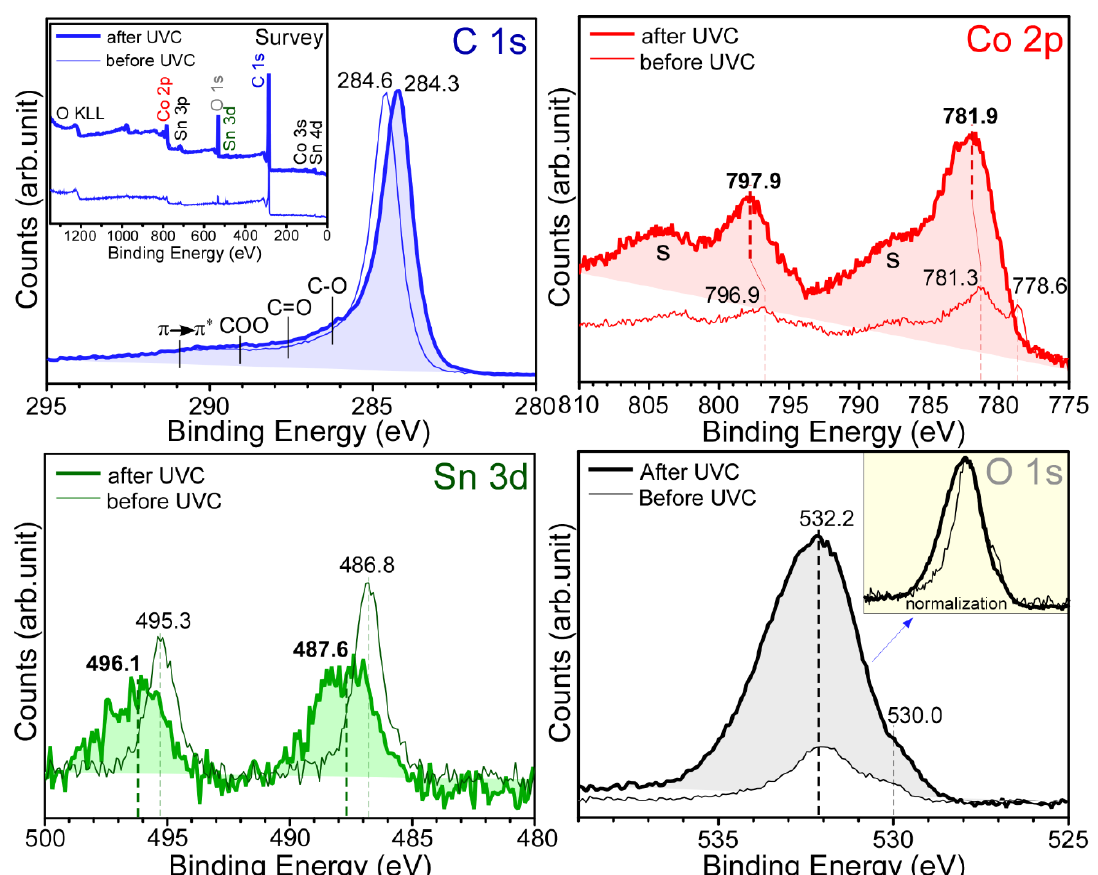
Figure 3. C 1s, Co 2p, Sn 3d, and O 1s XPS profiles of the selected (10 mol% SnO 2 ) sample before (thin line) and after (thick line) CO 2 reduction. The insets of C 1s and O 1s show survey XPS and normalized O 1s spectra, respectively.